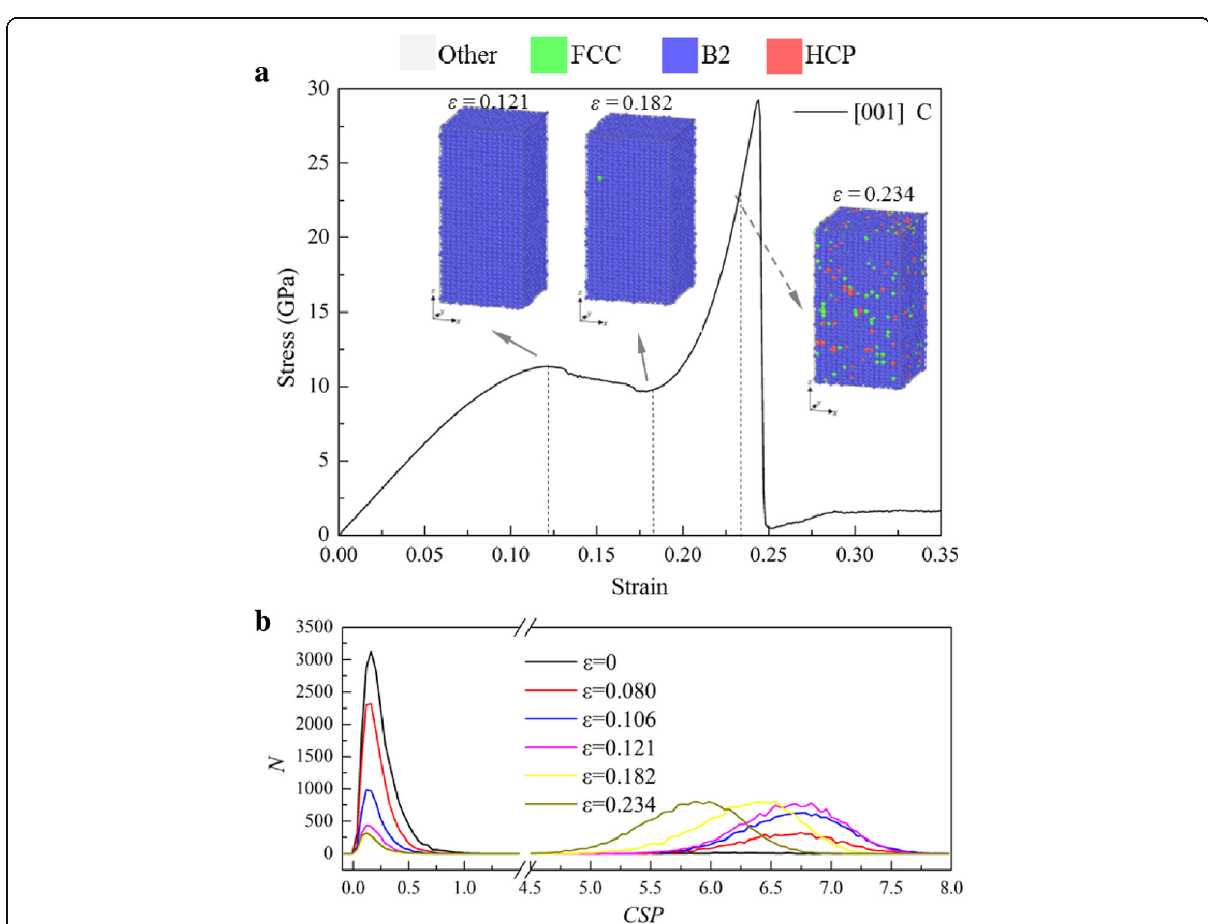
Fig. 9 Responses of the sample [001] under compression. a σ - ε curve and typical atomic configurations, with atoms colored with local structures identified by PTM. b N - CSP plots